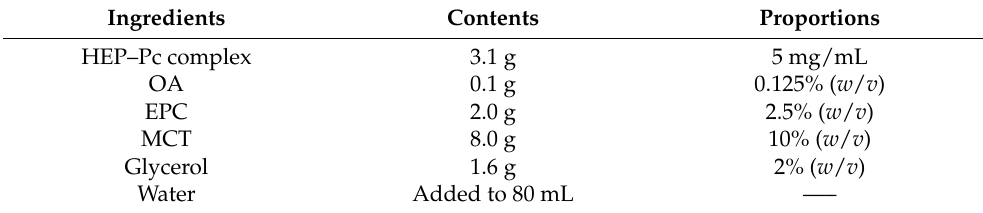
Table 1. Optimized formulation of HEP-SNEDDS.